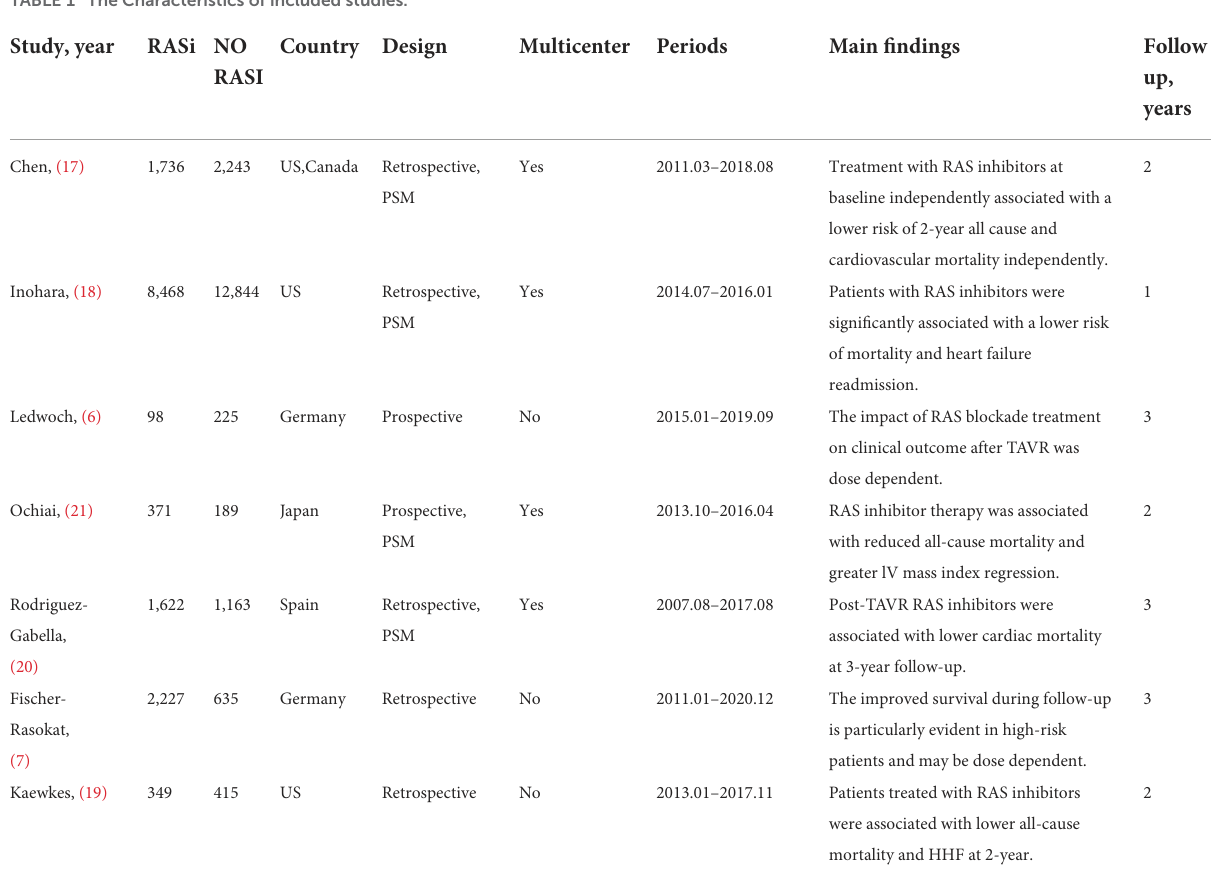
TABLE 1 The Characteristics of included